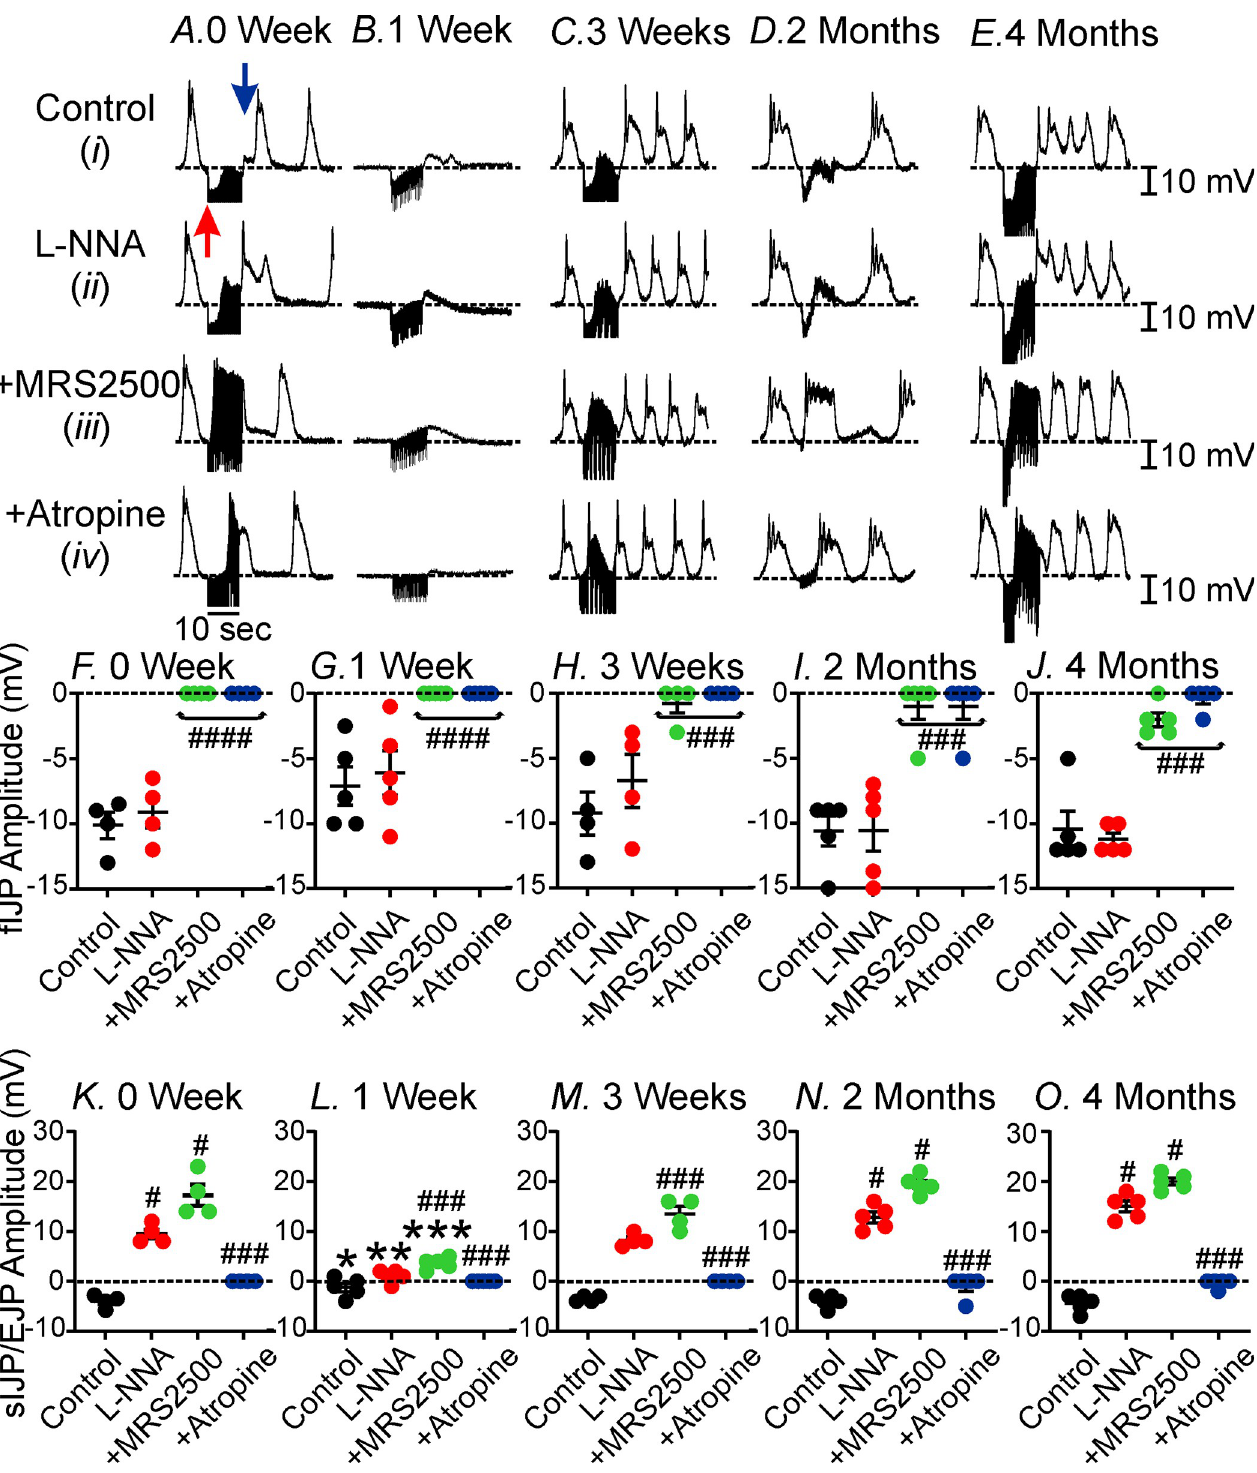
Fig 8. Changes in post-junctional responses in the gastric antrum in response to intense neural stimulation. Increasing the frequency of EFS (0.3 ms duration @ 5Hz and 10sec train durations) generated several distinct post-junctional neural responses in sham operated animals. Panels Ai,F&K , Under control conditions EFS activation of enteric motor nerves evoked an initial fIJP (red arrow) followed by a slow IJP (sIJP; blue arrow). In the presence of L-NNA (100 μ M, Panels Aii,F&K ) the amplitude of the fIJP was not affected but the sIJP was replaced by an excitatory junction potential (EJP). At the termination of EFS, the EJP was immediately followed by a slow wave. Panels Aiii,F&K, In the presence of L-NNA, MRS2500 (1 μ M), inhibited the EFS evoked fIJP but